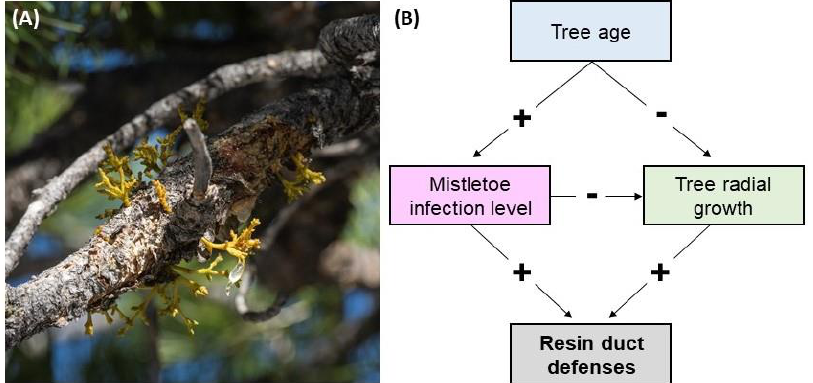
Figure 1. ( A ) Dwarf mistletoe infection causes swelling on a small brank of a lodgepole pine ( Pinus contorta ) (photo by Jeffry Mitton); ( B ) the hypothesized model of resin duct defenses as a function of mistletoe infection, tree age, and tree growth rate.